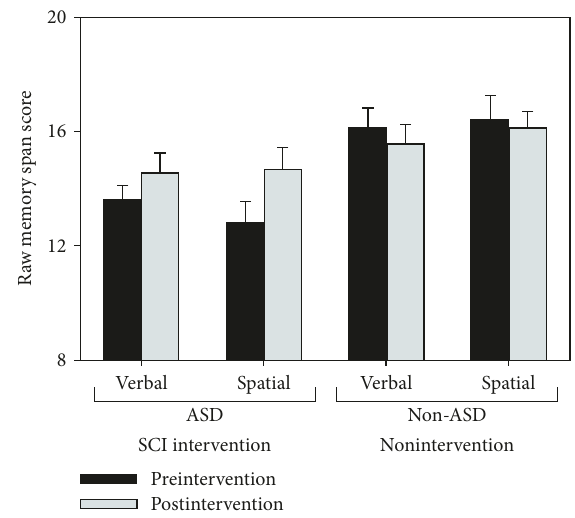
Figure 2: Mean raw scores for the working memory span tests, shown separately for each group (ASD and non-ASD), modality (verbal/digit and spatial), and timepoint (before and after interven- tion). Error bars represent standard error of the mean.